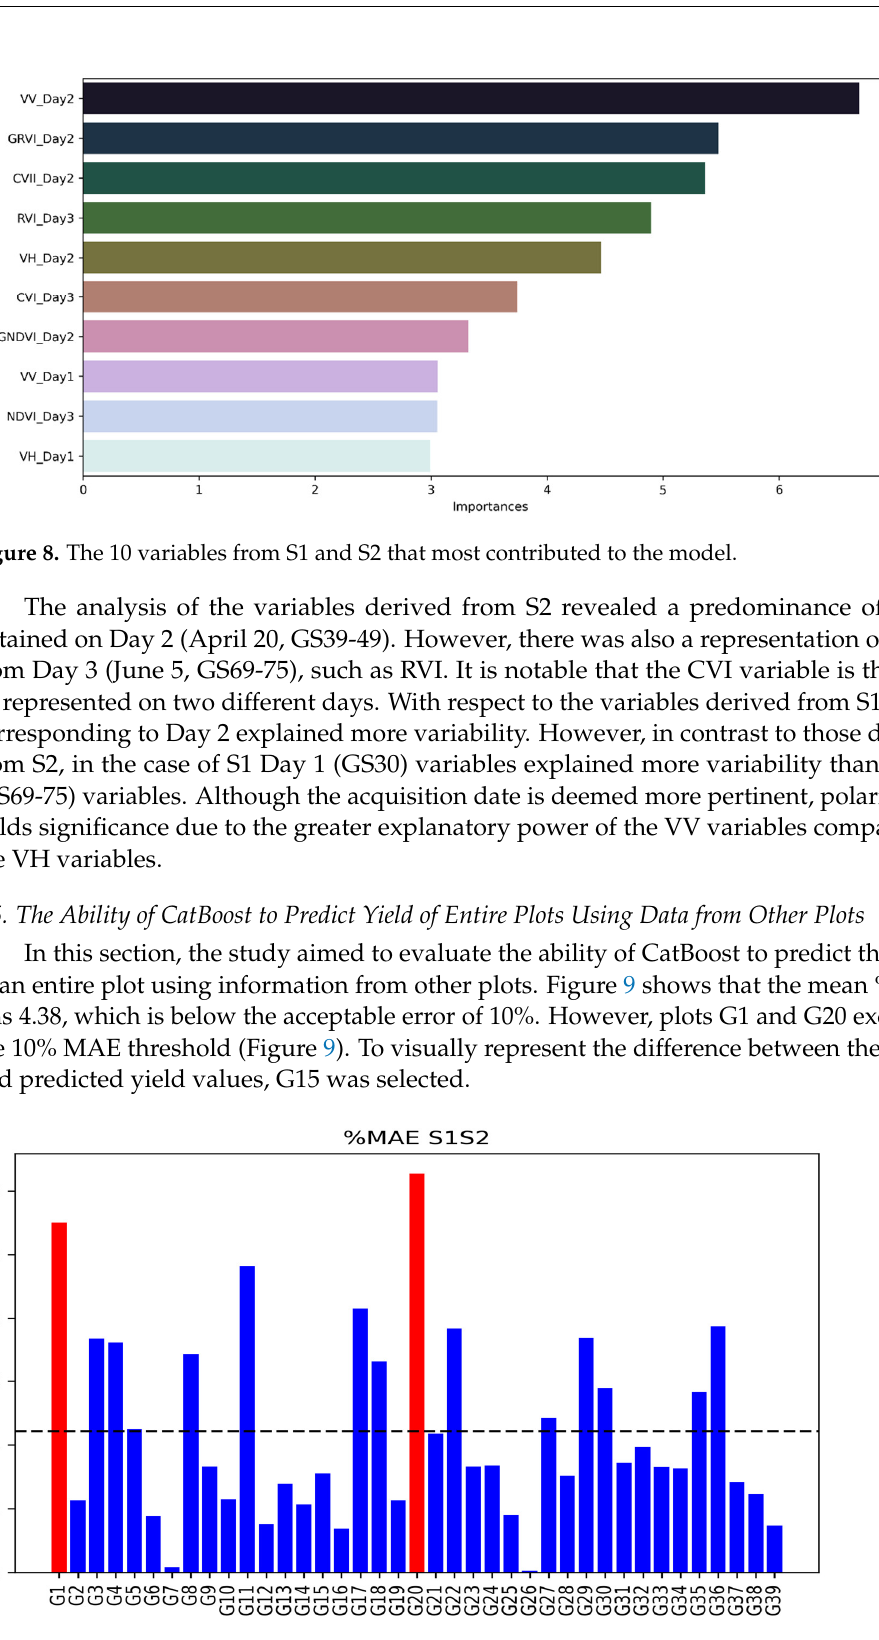
Figure 10. On the left, the classified wheat yield map of plot G15 (6.97 ha). On the right, classified wheat yield map based on the yield data estimated using the CatBoost algorithm with the S1S2 dataset for Days 1–3. The areas with low production are depicted in red, whereas those with high production are shown in blue. The accuracy and KI metrics were used to compare the two maps. 4. Discussion 4.1. Inclusion of Sentinel-1 and Sentinel-2 in the Yield Estimation Model In this study, an analysis was conducted to examine the impact of incorporating mul- tiple variables derived from S2 bands (VIs) and S1 backscatter information with VV and VH polarization obtained from various dates on yield prediction. The results revealed a consistent pattern in which the most favorable outcomes were consistently achieved when